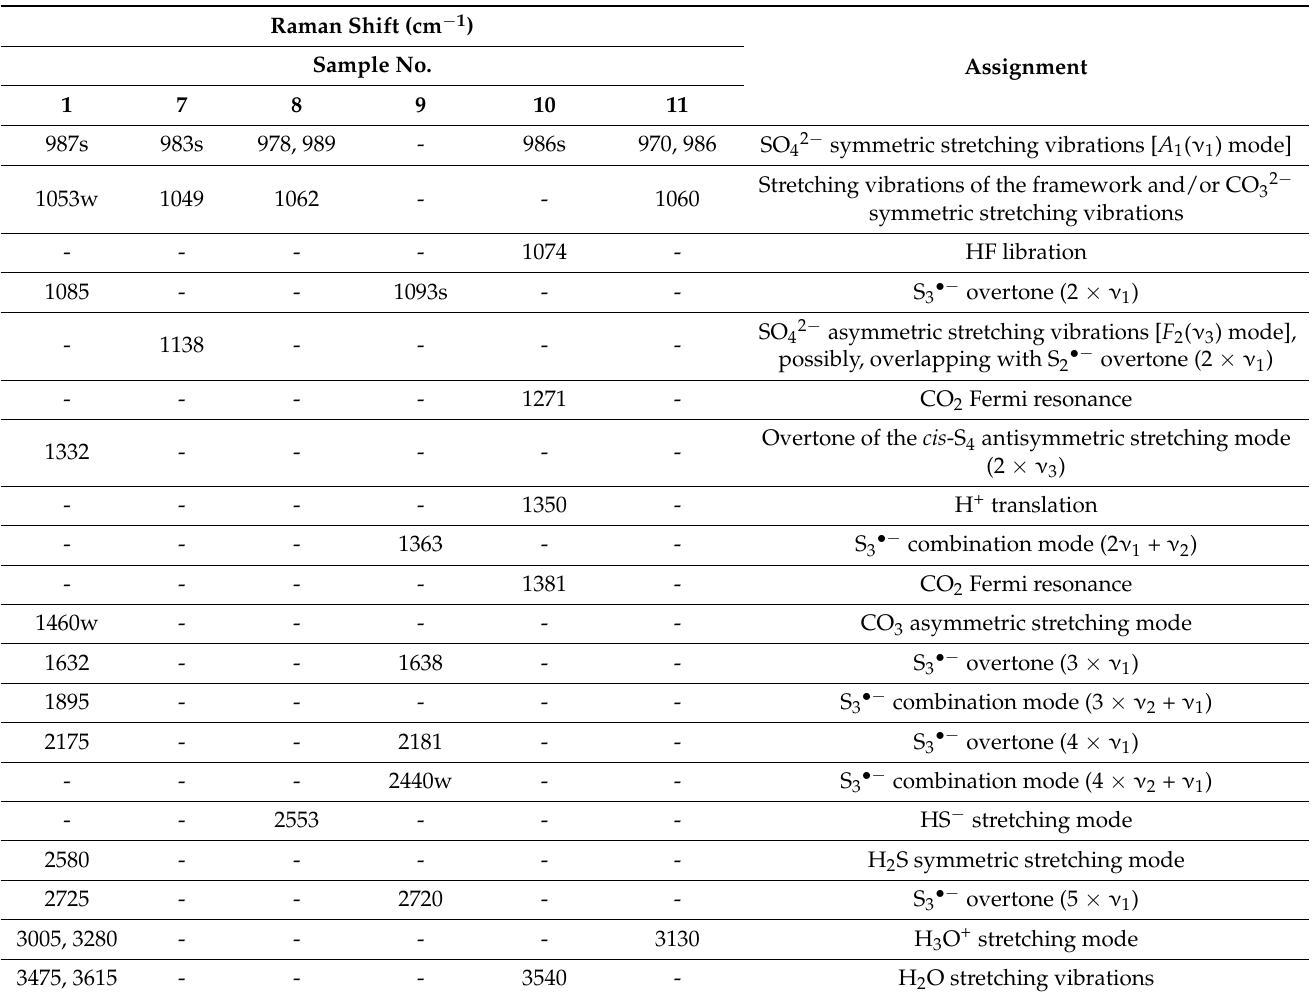
,Na)](Si 6 Al 6 O 24 ){Cl,HS,[F 0.5 (H 2 O) 2 ]} 2